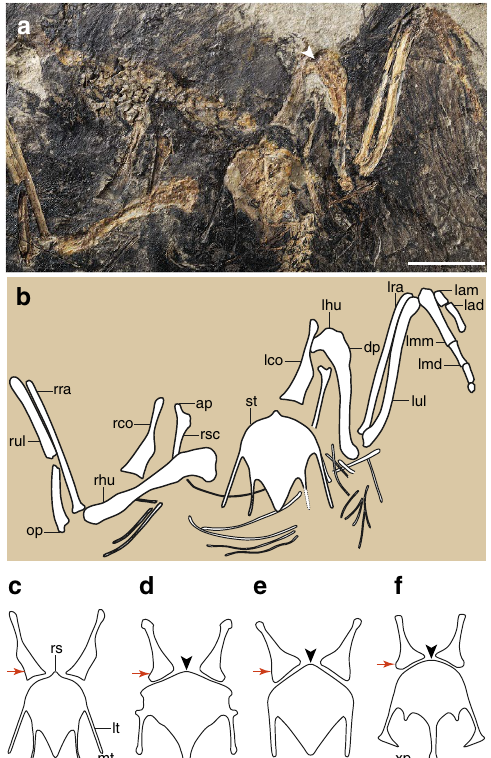
Figure 4 | Shoulder and forelimb of C. multidonta and some enantiornithines. ( a ) Photograph, ( b ) and line drawing of Cruralispennia , IVPP V21711; ( c – f ) reconstruction (not to scale) of the coracoids and sternum in Cruralispennia ( c ), Protopteryx ( d ), Eopengornis ( e ) and Parabohaiornis ( f ). ap, acromion process; dp, deltopectoral crest; lad, left alular digit; lam, left alular metacarpal; lco, left coracoid; lhu, left humerus; lmd, left major digit; lmm, left major metacarpal; lra, left radius; lt, lateral trabecula; lul, left ulna; mt, intermediate trabecula; op, olecranon process; rco, right coracoid; rhu, right humerus; rra, right radius; rs, rostral spine; rsc, right scapula; rul, right ulna; st, sternum; xp, xiphoid process. The white arrowhead in a indicates the circular fossa on the proximocranial surface of the humerus. The lateral margin of the distal half of the coracoid in Cruralispennia is weakly concave (red arrow in c ), in contrast to the strong convex form in other enantiornithines (red arrows in d – f ). The sternum of Cruralispennia bears a rostral spine, a structure not present in most enantiornithines (black arrowheads in d – f ). Scale bar,